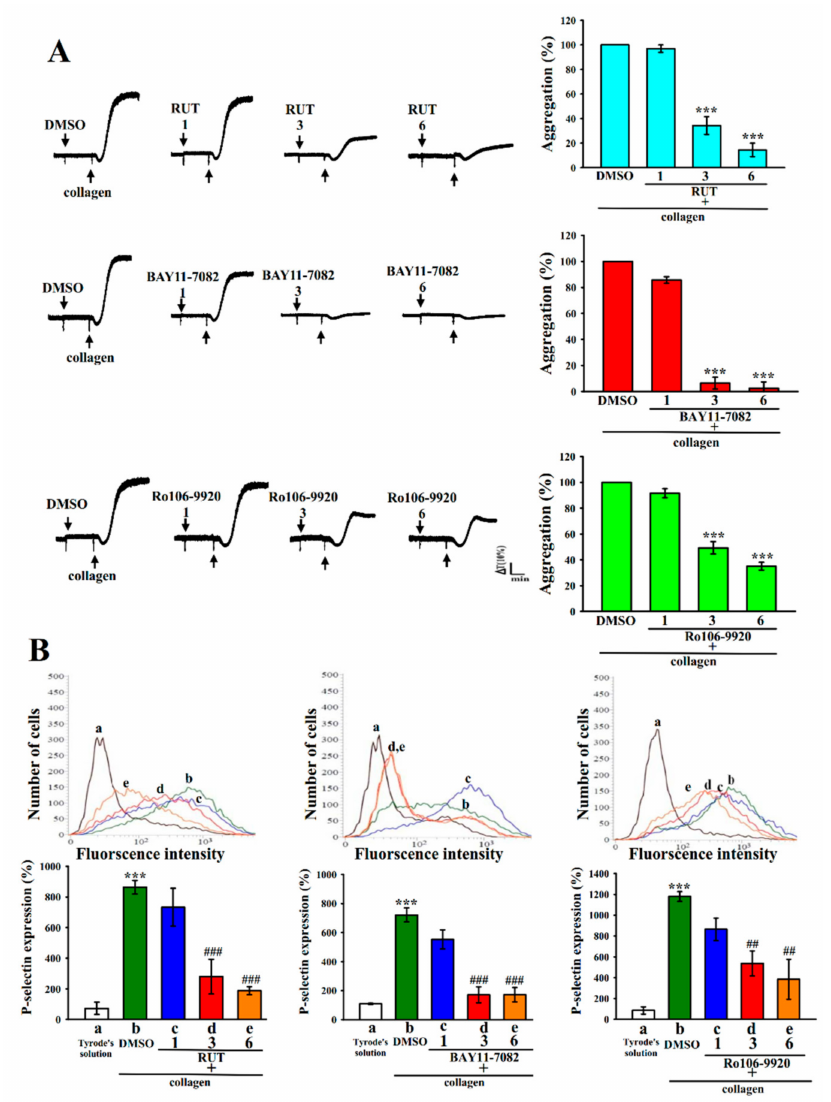
Figure 1. Comparison of the relative activities of rutaecarpine and NF- κ B inhibitors in platelet aggregation and P-selectin expression in human platelets stimulated by collagen. Washed human platelets (3.6 × 10 8 cells/mL) were preincubated with BAY11-7082, Ro106-9920, or rutaecarpine (RUT) at the same concentrations (1, 3, and 6 µ M), followed by the addition of collagen (1 µ g/mL) to trigger ( A ) platelet aggregation and ( B ) surface P-selectin expression (a, resting controla; b, collagen- activated; c, RUT 1 µ M, BAY11-7082 1 µ M or Ro106-9920 1 µ M; d, RUT 3 µ M, BAY11-7082 3 µ M or Ro106-9920 3 µ M; e, RUT 6 µ M, BAY11-7082 6 µ M or Ro106-9920 6 µ M) as described in the Materials and Methods. The corresponding statistical data are displayed in the right ( A ) or below ( B ) panel of each figure. Data are presented as the mean ± standard error of the mean ( n = 4). *** p < 0.001, compared with the 0.1% dimethyl sulfoxide (DMSO)-treated group ( A ) or resting group (Tyrode’s solution, ( B )); ## p < 0.01 and ### p < 0.001, compared with the 0.1% DMSO-treated group ( B